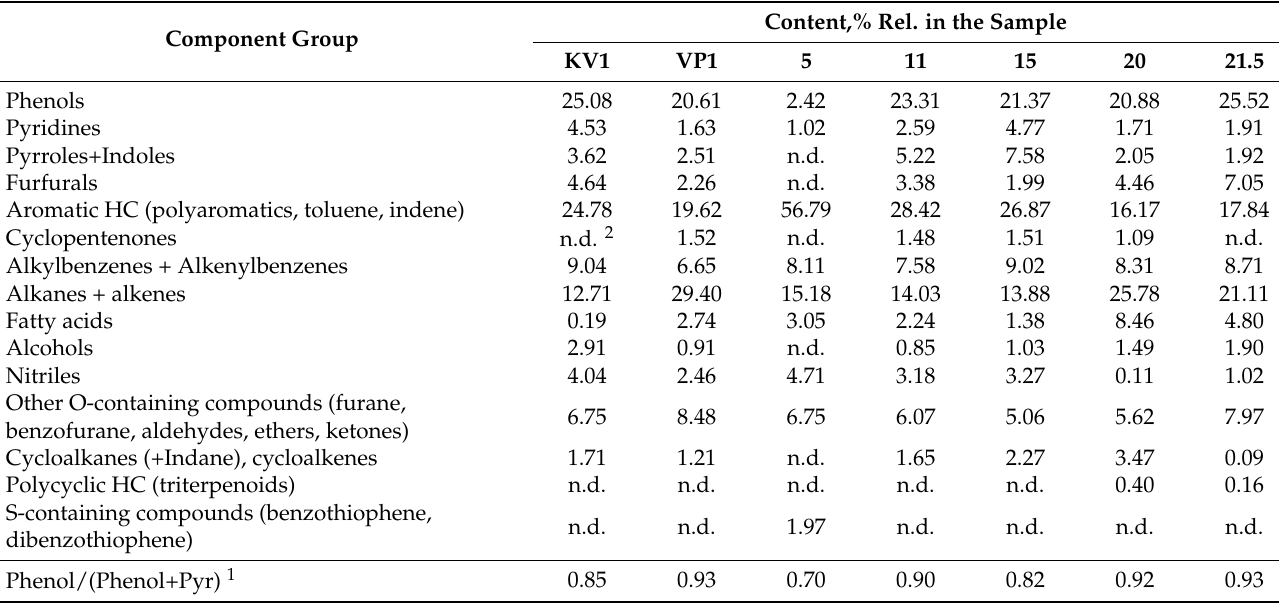
Table 3. Composition of the pyrolysis products of the Cape Muostakh sediments. Component